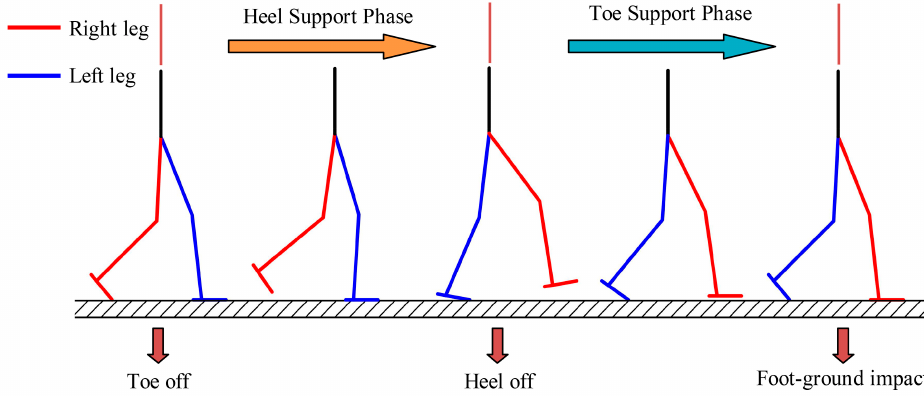
Figure 3. The bipedal robotic walking pattern, which consists of a heel support phase, a toe support phase, and an impact phase. The state transition events are toe off, heel off, and foot–ground impact, respectively.